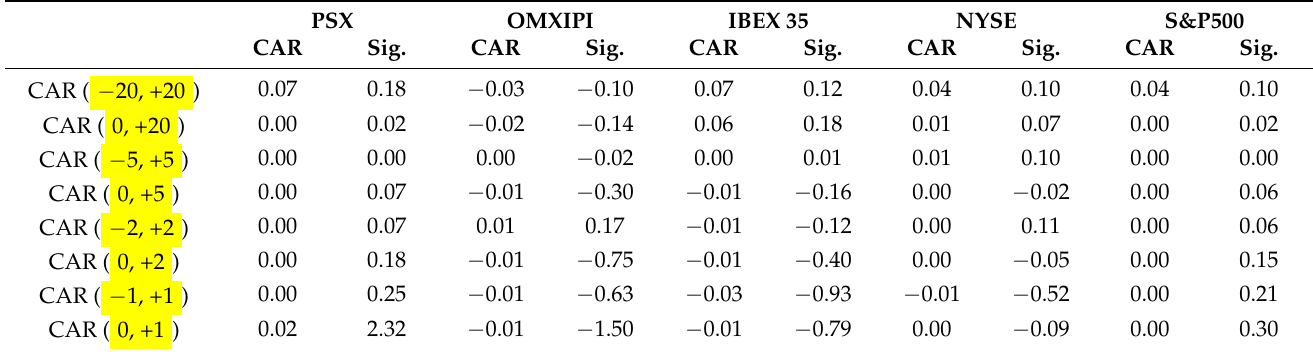
Table A10. Cumulative abnormal returns (News of Panama leaks).